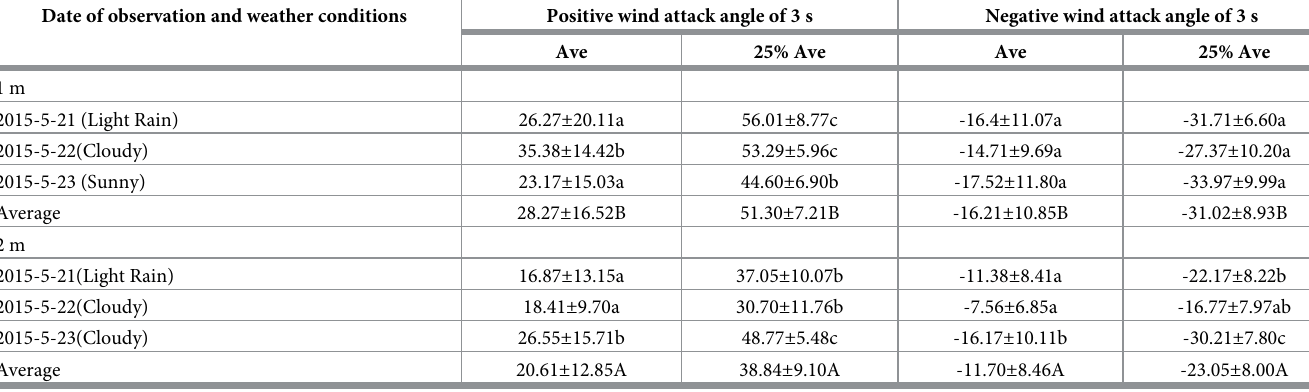
Table 2. Variation in the wind attack angle at the near-surface layer of the field under different weather conditions.